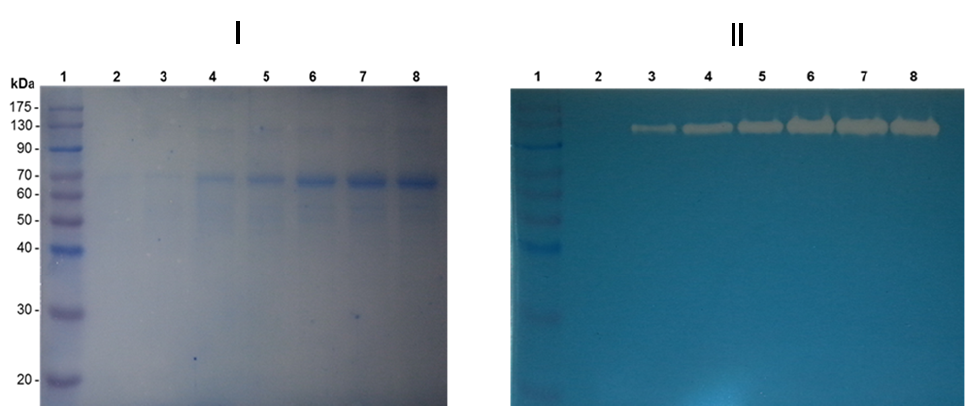
Figure 4. Analysis of the production of recombinant r – Tm DEX49A– Δ SP– Δ N30 in K. phaffii at shaker level in 100 mL of YPGlycerol medium. ( I ) SDS-PAGE of the fermented supernatant stained with CBB. 1—Molecular weight standard, PiNK Prestained Protein Ladder (NIPPON Genetics Europe, Germany); (2 to 8)—culture supernatants at hours 0, 4, 8, 12, 24, 36, 48. ( II ) Zymogram to detect dextranase activity; samples were analyzed in the same order from gel (A).